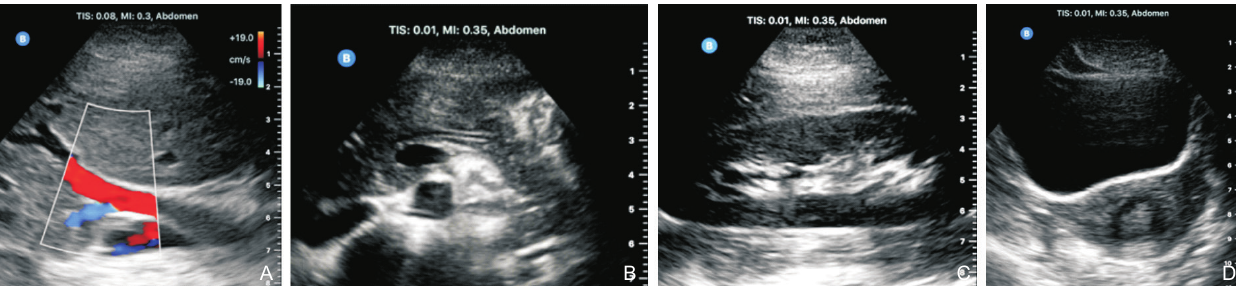
A B C Figure 3 With selection of a specific scanning application, Butterfly iQ demonstrated abdominal imaging of the liver and the portal vein (A), the pancreas (B), the kidney (C), and bladder with uterus (D).